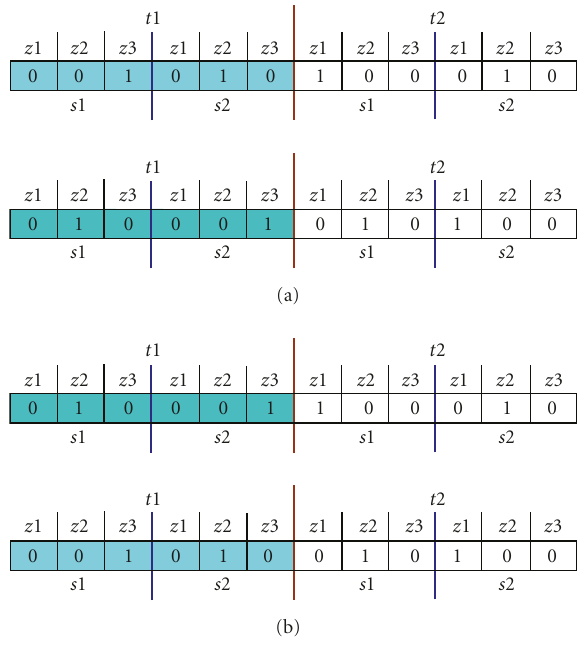
Figure 4: Time-exchange crossover operation between two chro- mosomes (a) before crossover and (b) after crossover. t 1 in both chromosomes are exchanged to generate two new